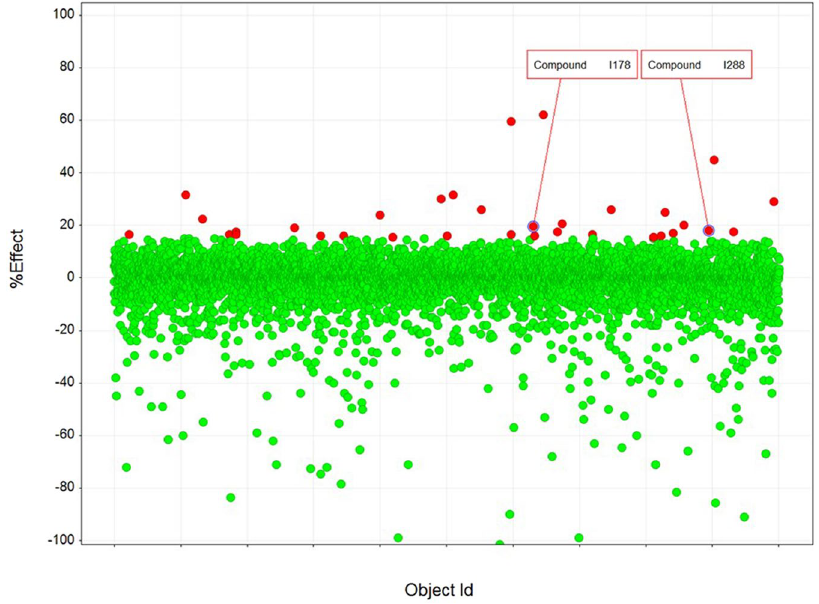
Figure 2. Single Point Testing for Compounds Capable of Disrupting. Interaction between EPAC1-CNB and 8-NBD-cAMP in HTS Compounds from the BioAscent library of diverse lead like structures were assessed in 384 well plates at 10 µ M with 0.25% DMSO final, n = 1 over two testing days. Responses (% effect) from each compound tested are shown. For the screen a selection cut-off of 15% was calculated using the median plus three times the robust standard deviation (scaled median absolute deviation) of the percentage inhibition across all compound wells, generating 33 hits (indicated with red dots) and a 0.67% hit rate. The screen performed extremely well with consistent levels of maximum (Max) and minimum (Min) control responses, Z’ values and S/B ratios. %CV values were calculated for matching control wells as described (materials and methods) and were below 10%, indicating excellent inter-plate and inter-day